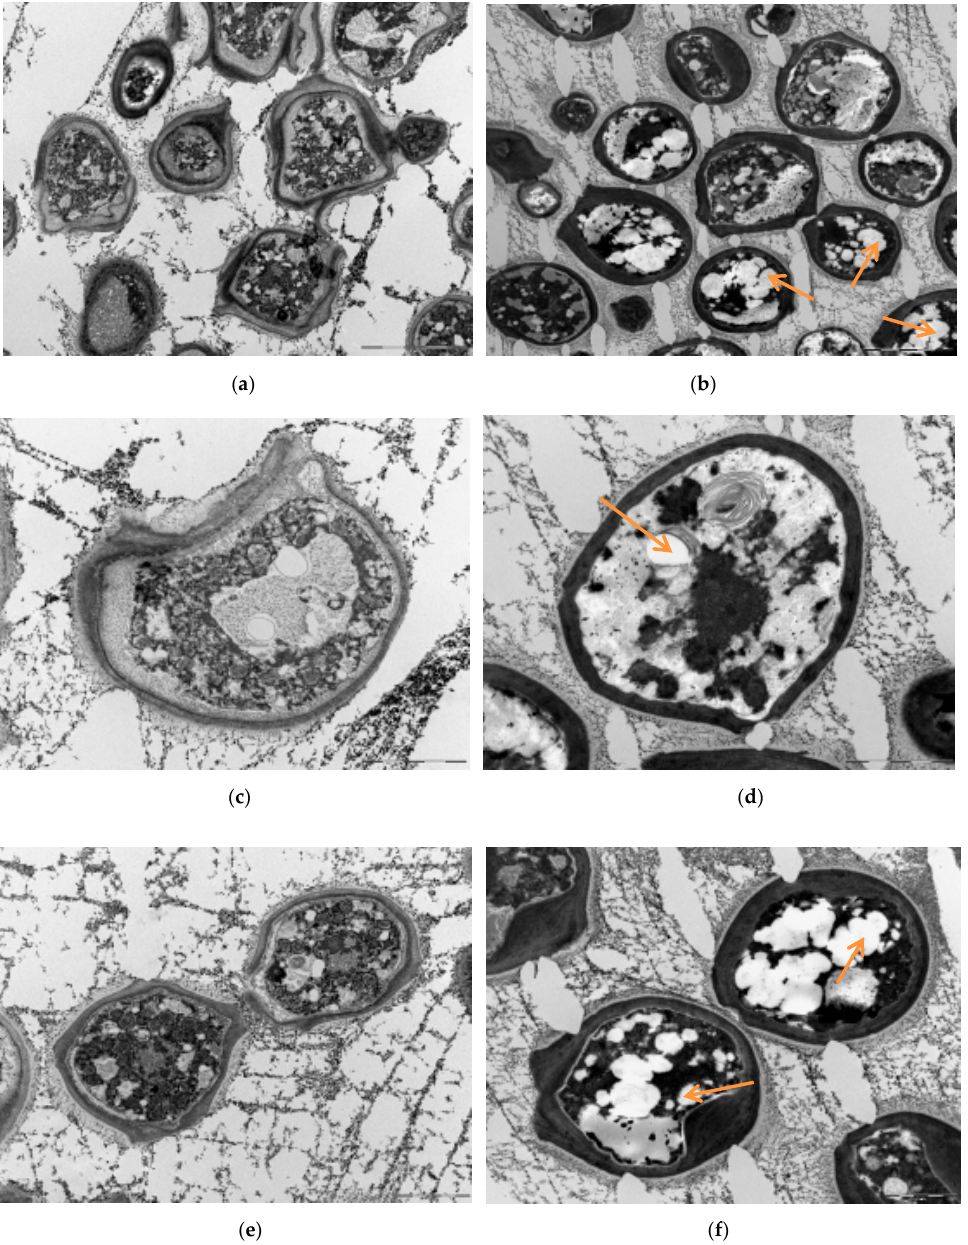
Figure 8. Transmission electron microscopy of red yeast cells cultivated on glucose at different C/N ratios. Formation of lipid bodies under nutrition stress. Lipid bodies are demonstrated by arrows. ( a )